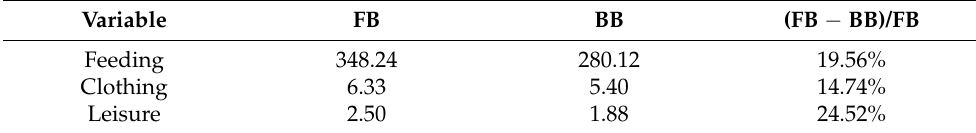
Table 6. Resampling-based variance estimates (divided by 10 6 ) for the case